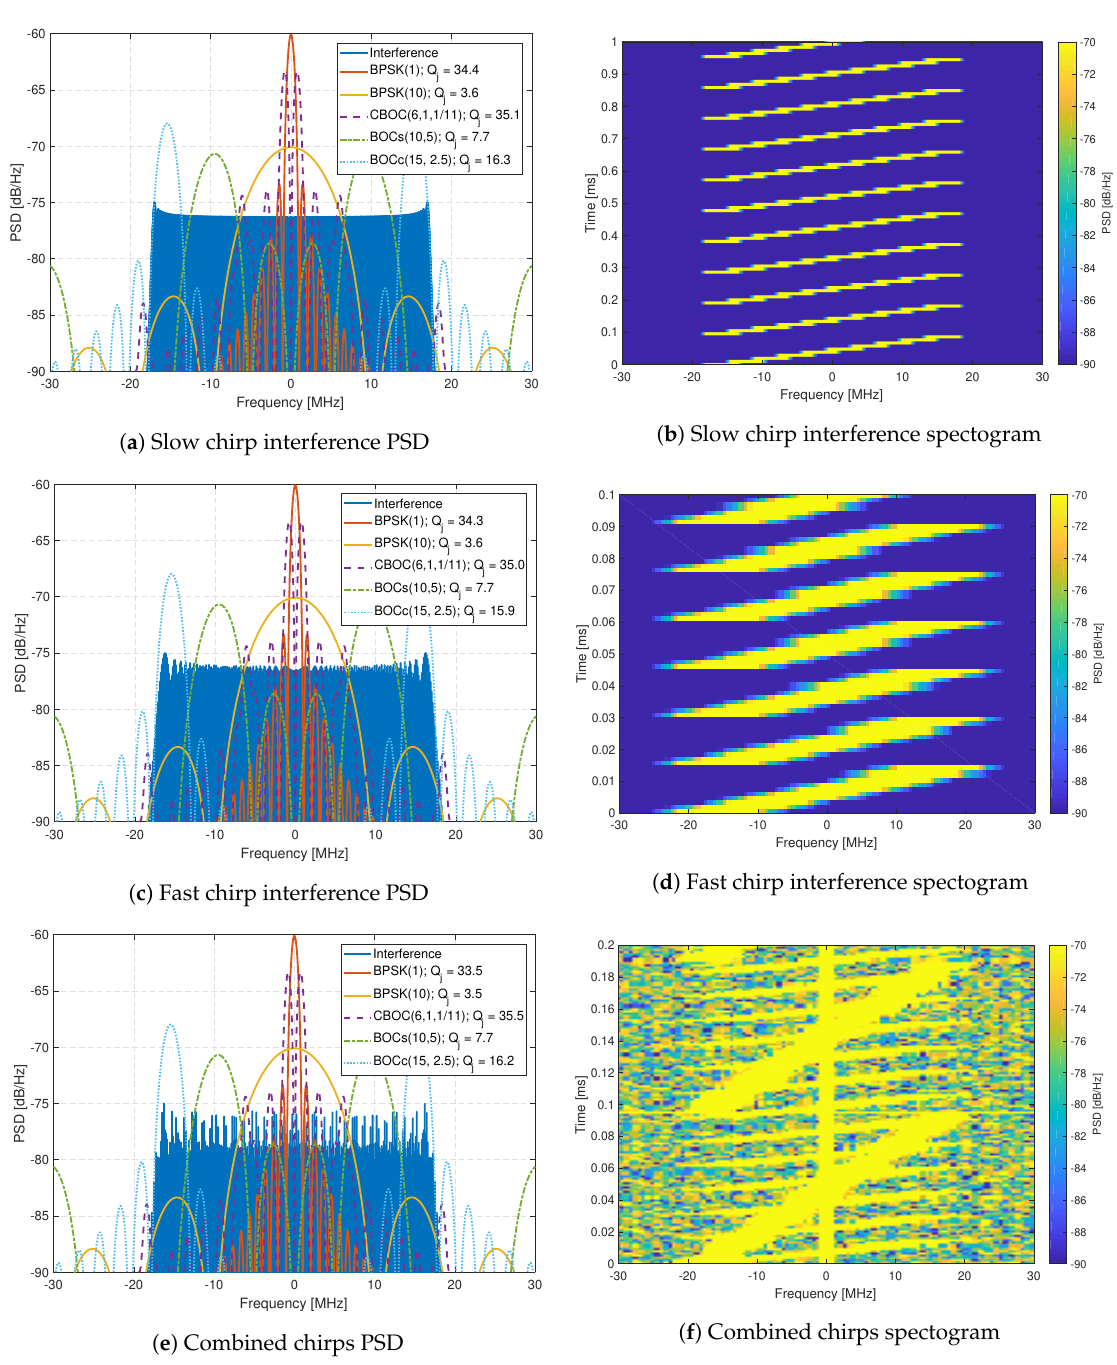
Figure 11. Analysis of chirp